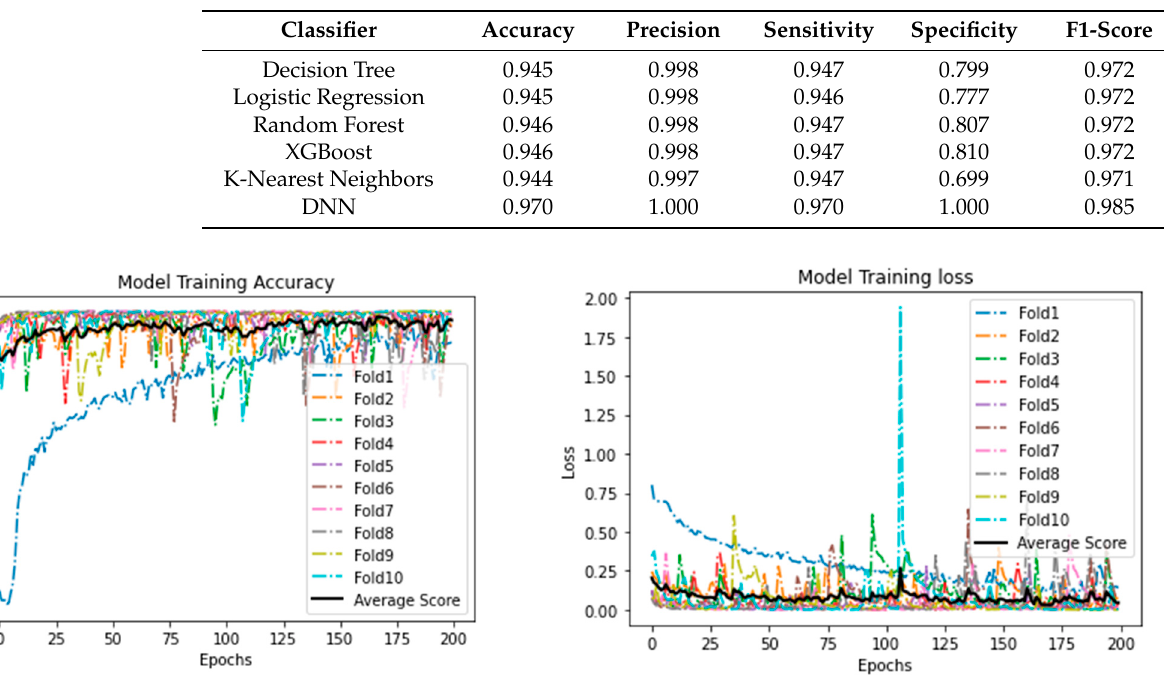
Figure 5. Proposed Deep Learning model: validation accuracy and loss. In medical applications, the false-negative rate should be minimized as much as pos- sible, as people who test positive for a particular disease should take the necessary pre- cautions and receive the care and treatment they need. Especially in the case of this pan- demic, it is imperative that people with COVID-19 are aware of their condition so that they refrain from spreading their infection to others and take all precautionary measures required. Therefore, one of the most important measures in this research is sensitivity. A high sensitivity corresponds to a low false-negative rate. Among all the reviewed litera- ture, this research resulted in the highest sensitivity of 0.970. Moreover, although false positives are not as significant as false negatives in medi- cine, it is still important to minimize the false positive rate. False positives have the asso- ciated hassle of staying at home for 14 days, unable to carry out responsibilities. Of the reviewed literature, this research also provides the highest precision of 1.000. Because both the sensitivity and precision achieved in the proposed research is higher than the studies mentioned in the literature, the F1 score obtained is also the high- est, namely, 0.985. The F1 score is one of the most important measures in the current study because it takes into consideration the subtleties of class imbalances and/or the varying cost of false positives and false negatives. Furthermore, [24] uses the same dataset as that used in the current study. While they achieved a reported accuracy of 0.9375, this research surpassed that accuracy, with an acquired value of 0.970. This study aimed to develop DL and ML models using sociodemographic and brief clinical (symptoms and patient comorbidities) attributes. The proposed models can better